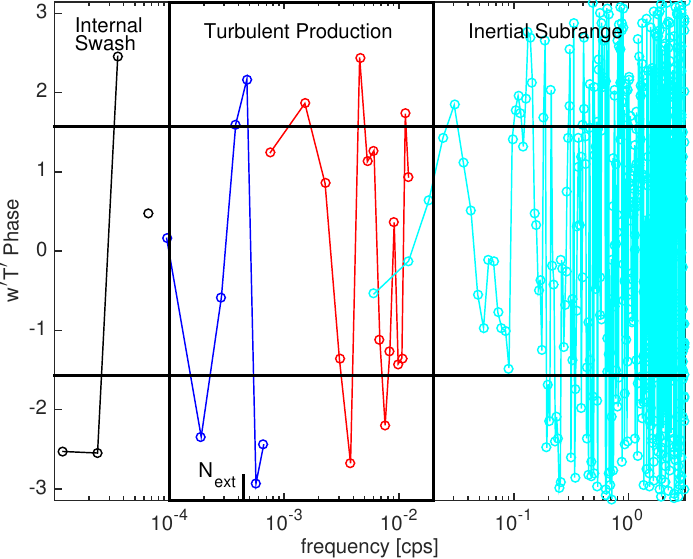
Figure 15. w (cid:48) T (cid:48) phase. Phase in the production regime bounces between ± π /2. Color coding is associated with increased averaging within the frequency domain.